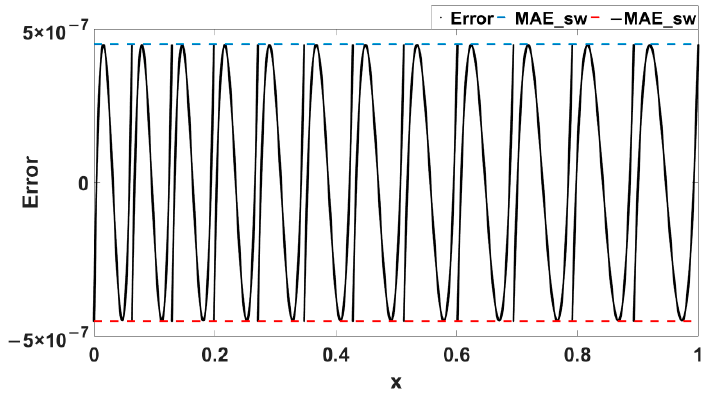
√ x with 12 segments in